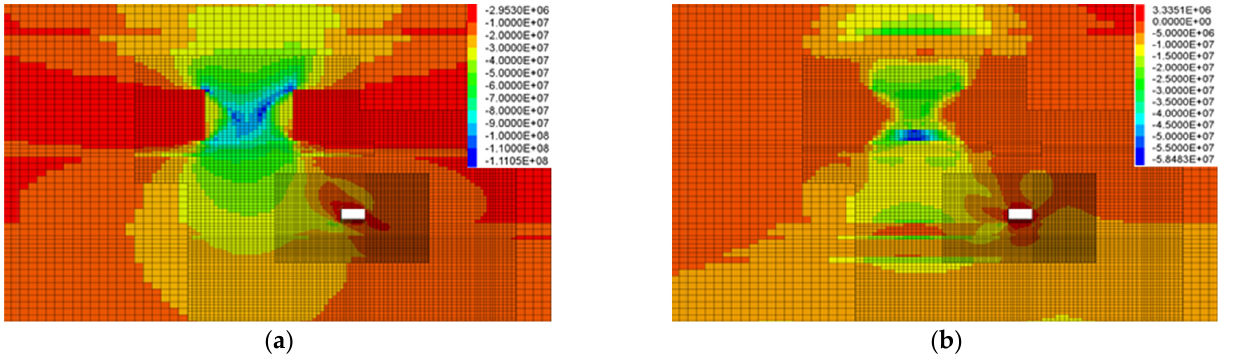
Figure 24. Principal stress distribution contour of the roadway’s surrounding rock when the coal column is 25 m. ( a ) σ 1 cloud. ( b ) σ 3 cloud.